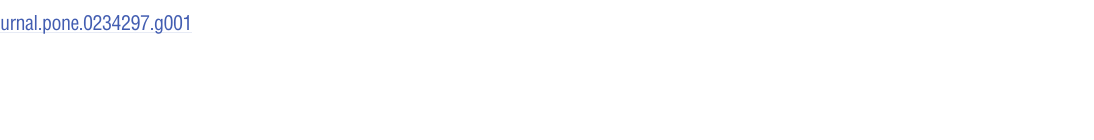
PLOS ONE | https://doi.org/10.1371/journal.pone.0234297 June 10, 2020 5 /